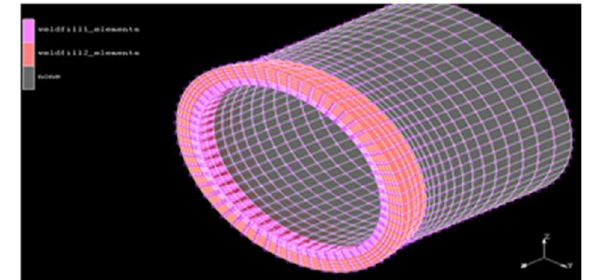
Figure 1 3D model generation